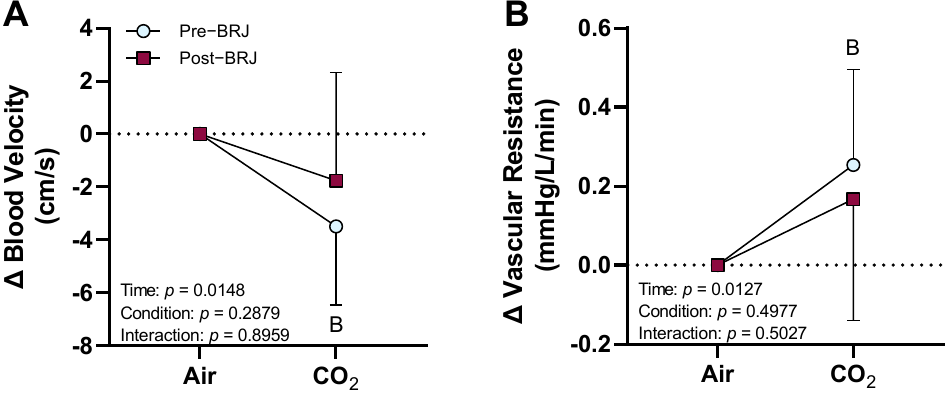
Figure 4. Effect of beetroot juice (BRJ, condition) at three hours post-consumption on blood velocity and vascular resistance in the renal artery during five minutes of CO 2 breathing (time). Data are presented as the means ± SD as the change from room air baseline. Data were analyzed using a two-way repeated-measures ANOVA with post hoc Sidak’s tests to com- pare changes from room air baseline and to compare differences between pre-and post-beetroot juice consumption during CO 2 breathing. ( A ) renal artery blood velocity; ( B ) renal artery vascular resistance. n = 10 (4 females and 6 males). B different from room air baseline ( p ≤ 0.0177).